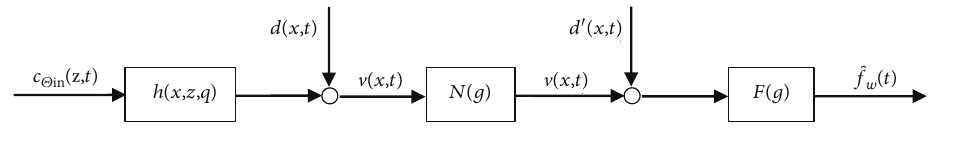
Figure 3: Spatial-temporal Wiener